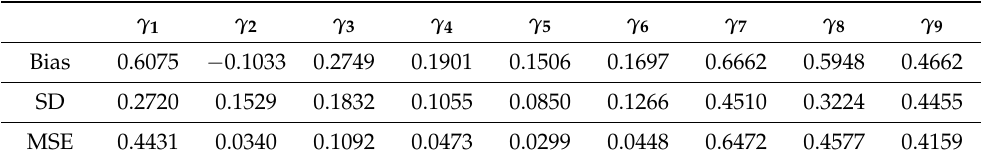
Table 8. Bias, SD and MSE evolutions with respect to the parameter γ variation for PLGSIMF with the logit link function and n =